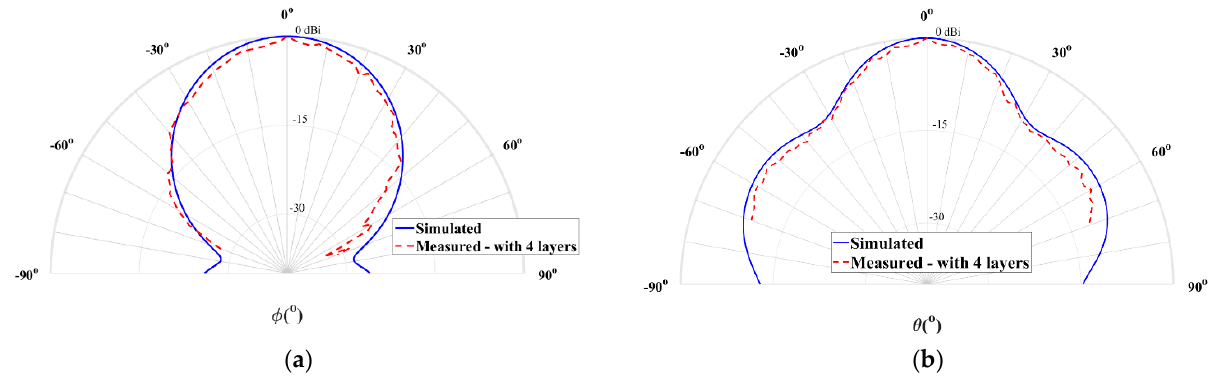
Figure 9. Simulated and measured normalized radiation pattern at 28 GHz of the 4-layer horn antenna with conductive paint: ( a ) plane θ = 90° and ( b ) plane ϕ = 90°.